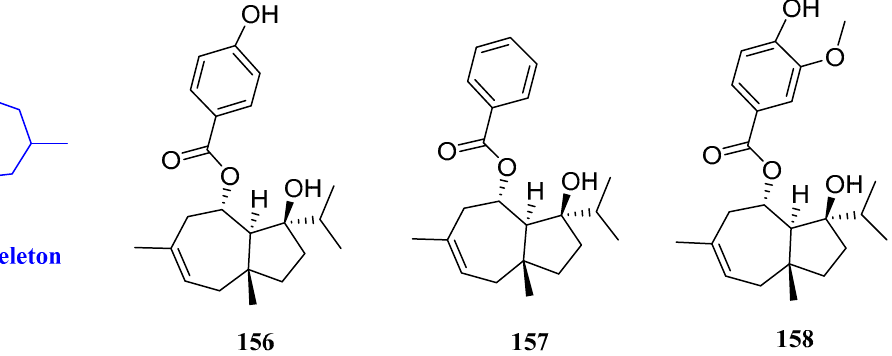
Figure 17. Structures of daucane - type sesquiterpenoids 156 ‒ 158 .